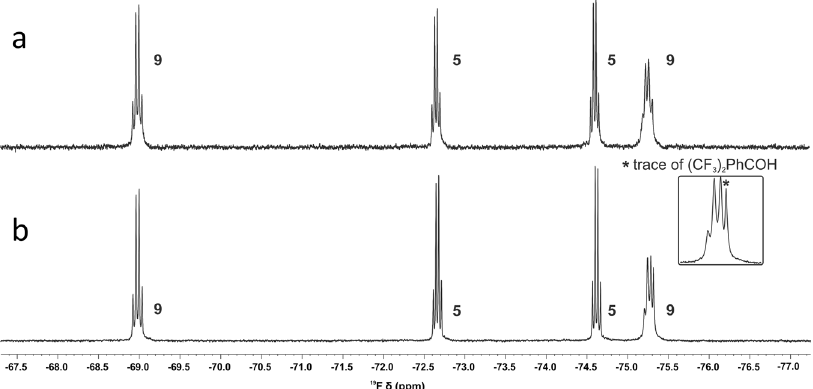
Fig. 9 Enhanced air stability of the labile adduct 9. 19 F NMR spectra of 9 (0.01 mmol) kept in the glove box ( a ) and left on the bench in the air for 2 h ( b ). NMR conditions: [W] = 0.01 M, C 6 D 6 , 298